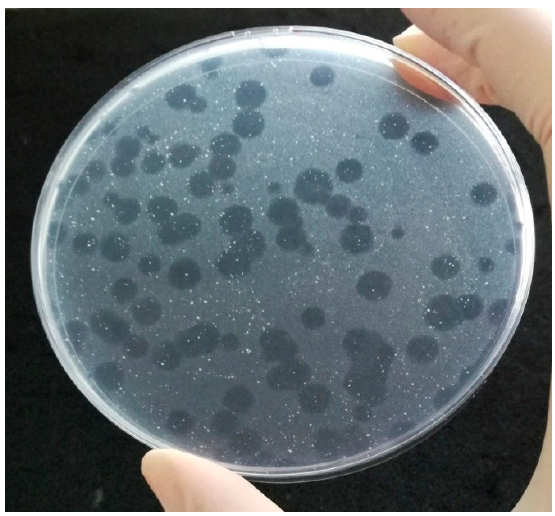
Figure 2. The positive sample determined by phage amplification assay.